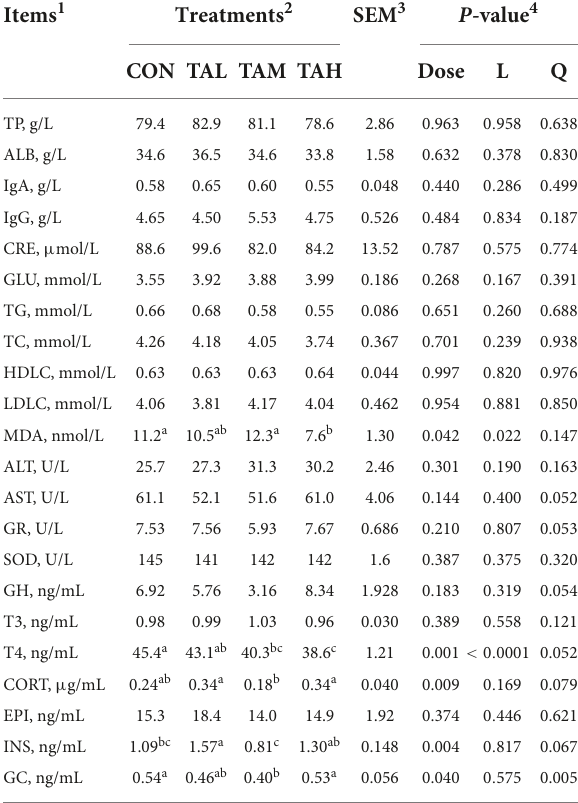
TABLE 4 Effects of tannic acid at different supplemental levels on biochemical and physiological parameters in the blood serum of Holstein